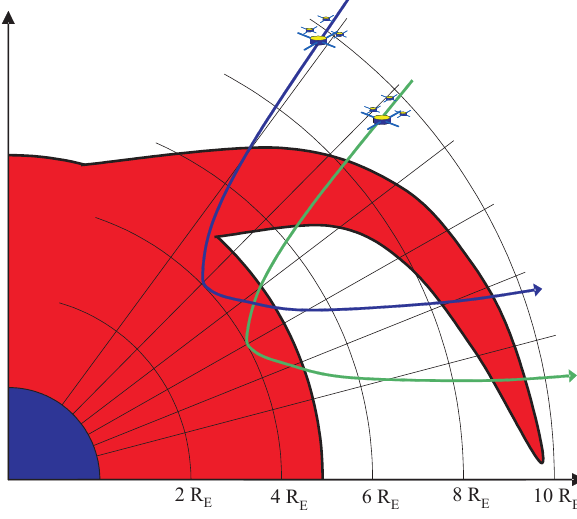
Fig. 2. Frequency-time spectrogram measured on 18 July 2005 by the WHISPER instrument onboard C1. The inbound plume cross- ing is shown. Time and plasma frequency of the outer and inner boundaries of the plume are shown, as well as the time and plasma frequency of the maximum recorded during the plume crossing.